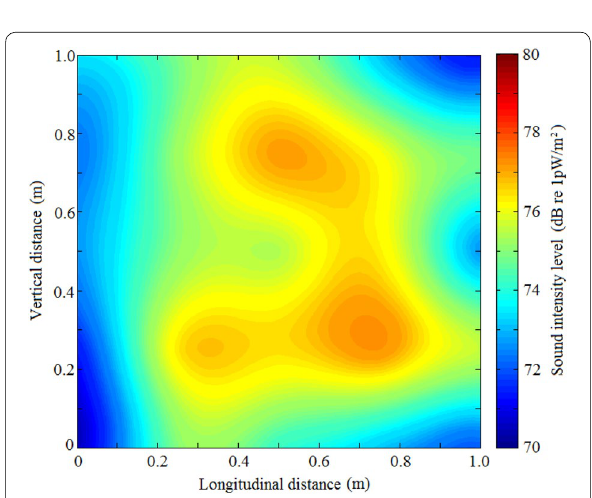
Figure 23 Sound intensity level of the interior sidewall (100–5000